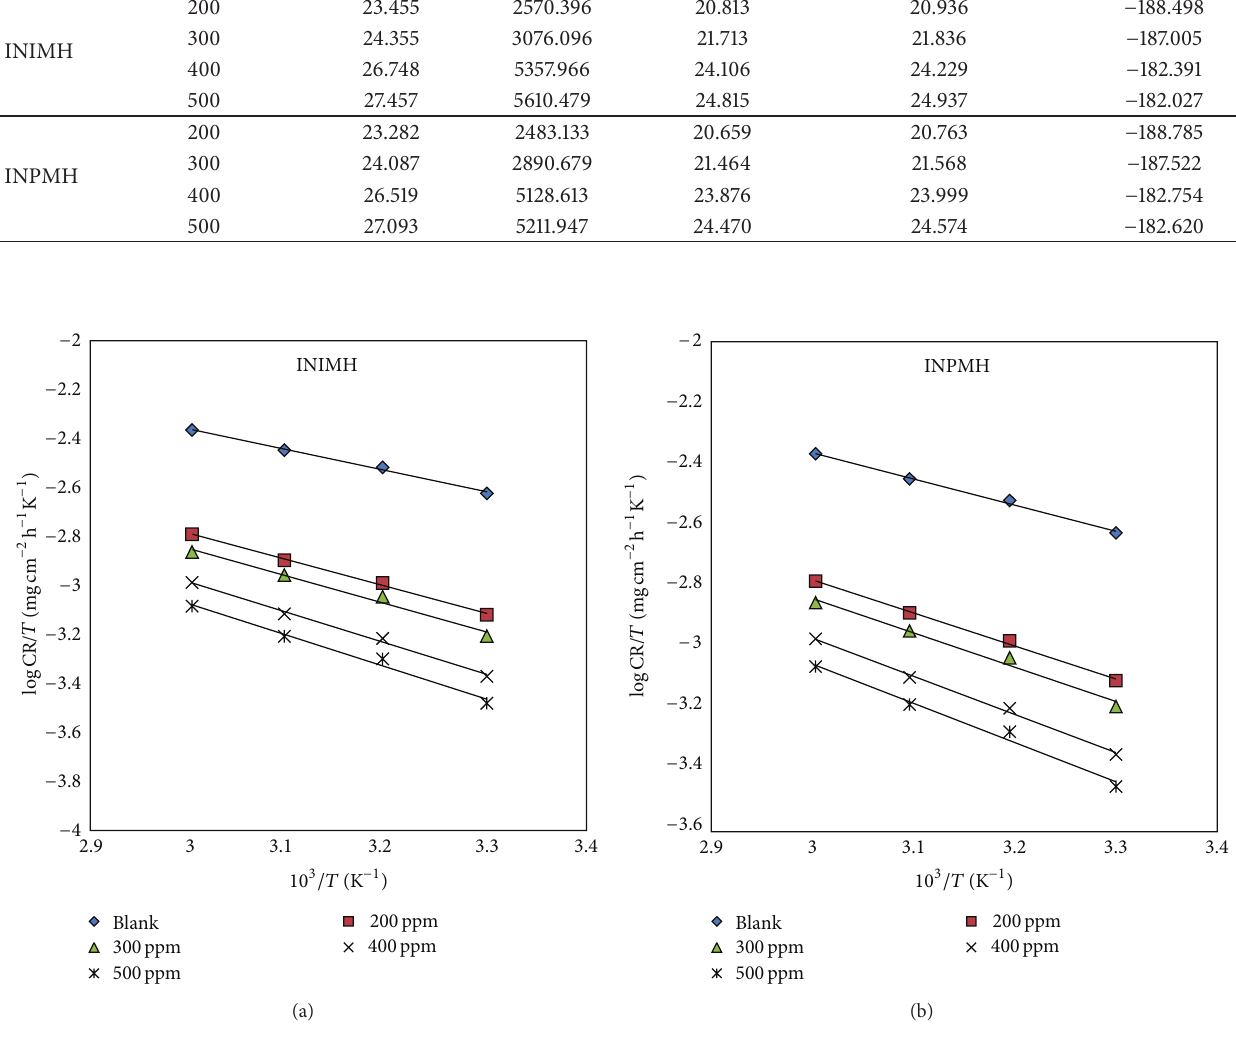
where 𝑅 is the universal gas constant, 𝑇 is the absolute temperature, 𝑁 is the Avogadro’s number, and ℎ is Planks constant. The values of Δ𝐻 𝑎 and Δ𝑆 𝑎 were obtained from the slope and intercept of the previous plot. The obtained Δ𝐻 𝑎 values are in good agreement with the calculated Δ𝐻 𝑎 from the